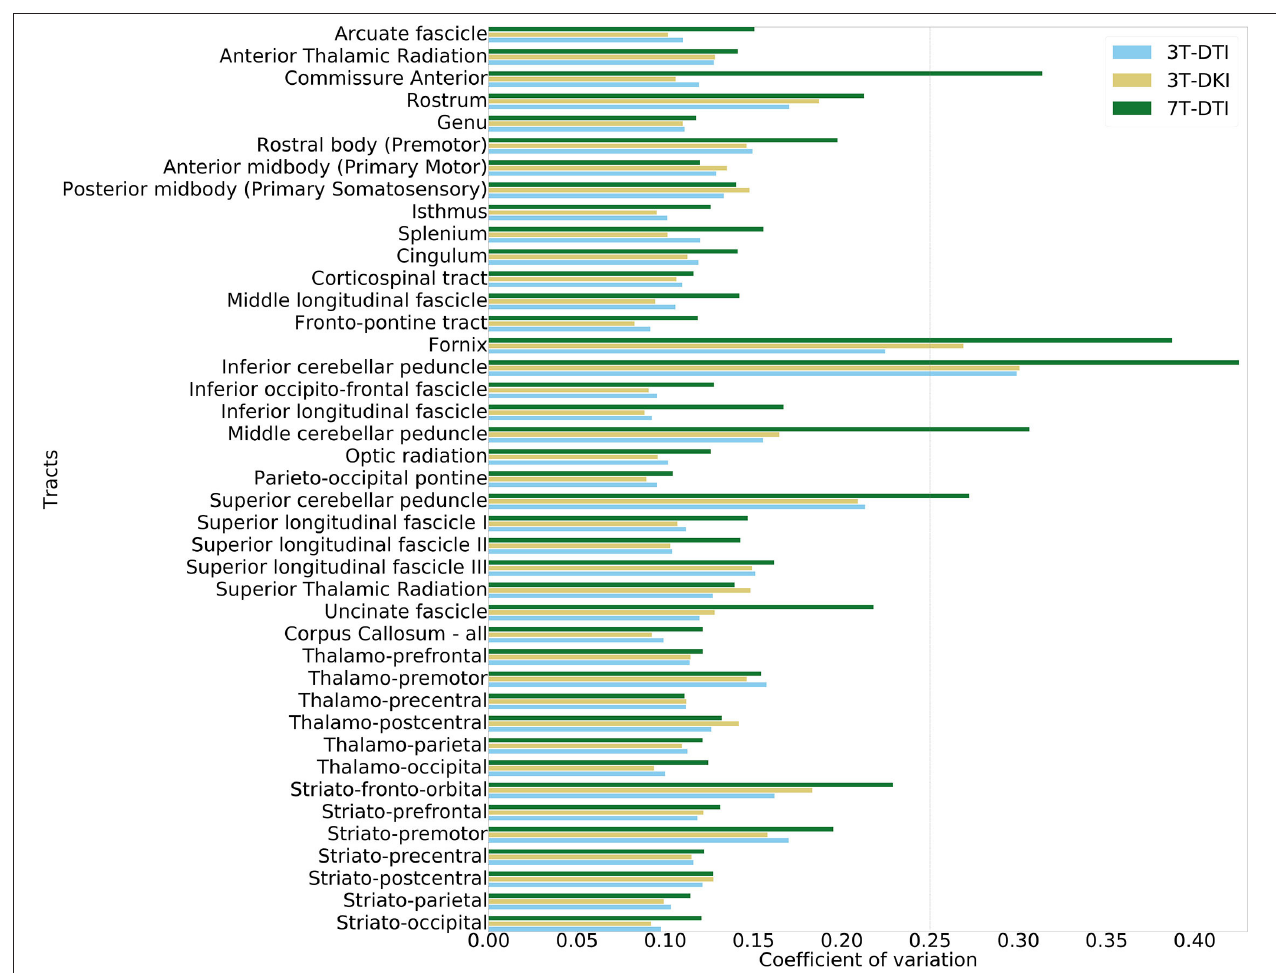
FIGURE 4 | Evaluation of volume variation in the tracts. The tract segmentation was based on data acquired with 3T-DTI (cyan), 3T-DKI (gold), and 7T-DTI (green) data. In cases where TractSeg provides the left and right part of one fiber-tract as two different tracts (e.g., in case of left and right arcuate fasciculus), the left and right parts of the tract were averaged. The vertical dashed line shows the threshold of 0.25, which corresponds to a high